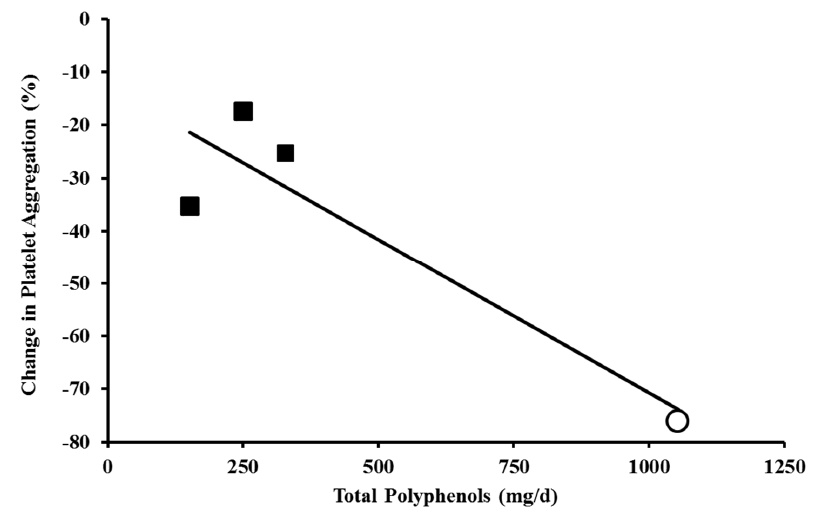
Figure 2. Dose ‐ response for polyphenol ‐ containing foods and beverages on systolic blood pressure ( A ) and diastolic blood pressure ( B ). Regression equations: Change in Systolic BP = (Total Figure 3. Relationship between the intake of polyphenol ‐ containing foods and ex vivo collagen ‐ polyphenols/day × − 0.00294) − 1.2585. Change in Diastolic BP = (Total polyphenols/day × − 0.00205) − induced platelet aggregation. Concord grape juice: Keevil et al. [60]. 0.2279. Concord grape